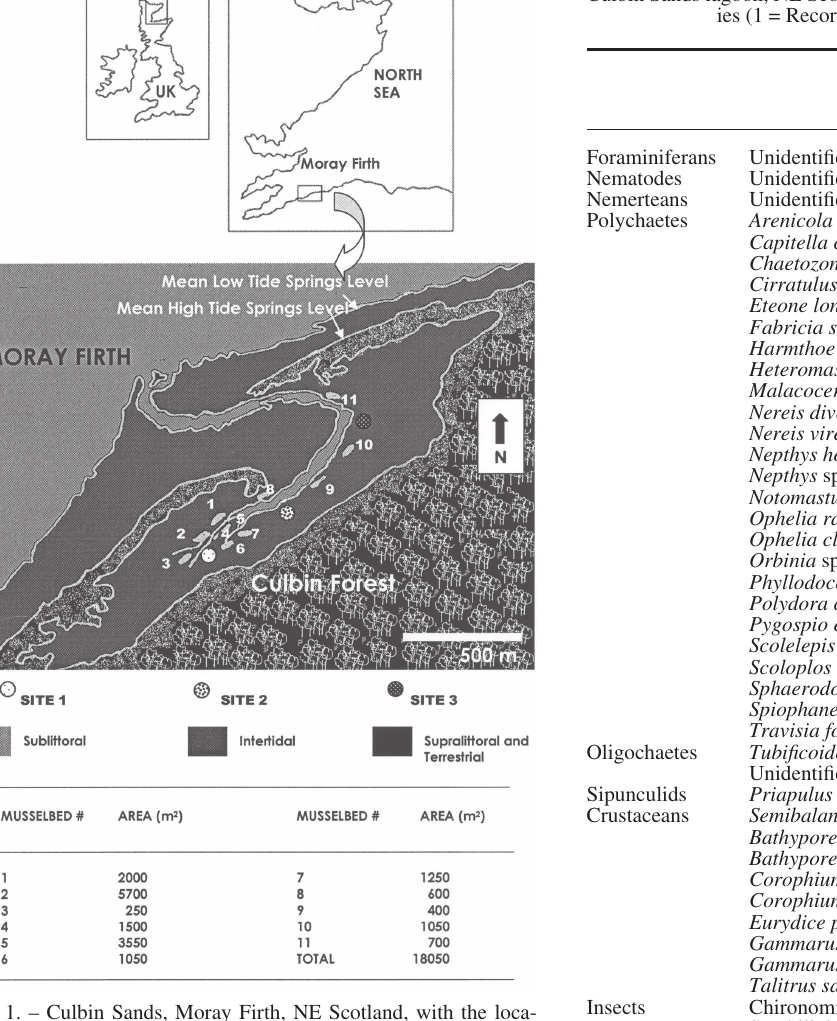
Fig . 1. – Culbin Sands, Moray Firth, NE Scotland, with the loca- tion of the three sampled sites (1-3) and the musselebeds of Mytilus edulis indicated